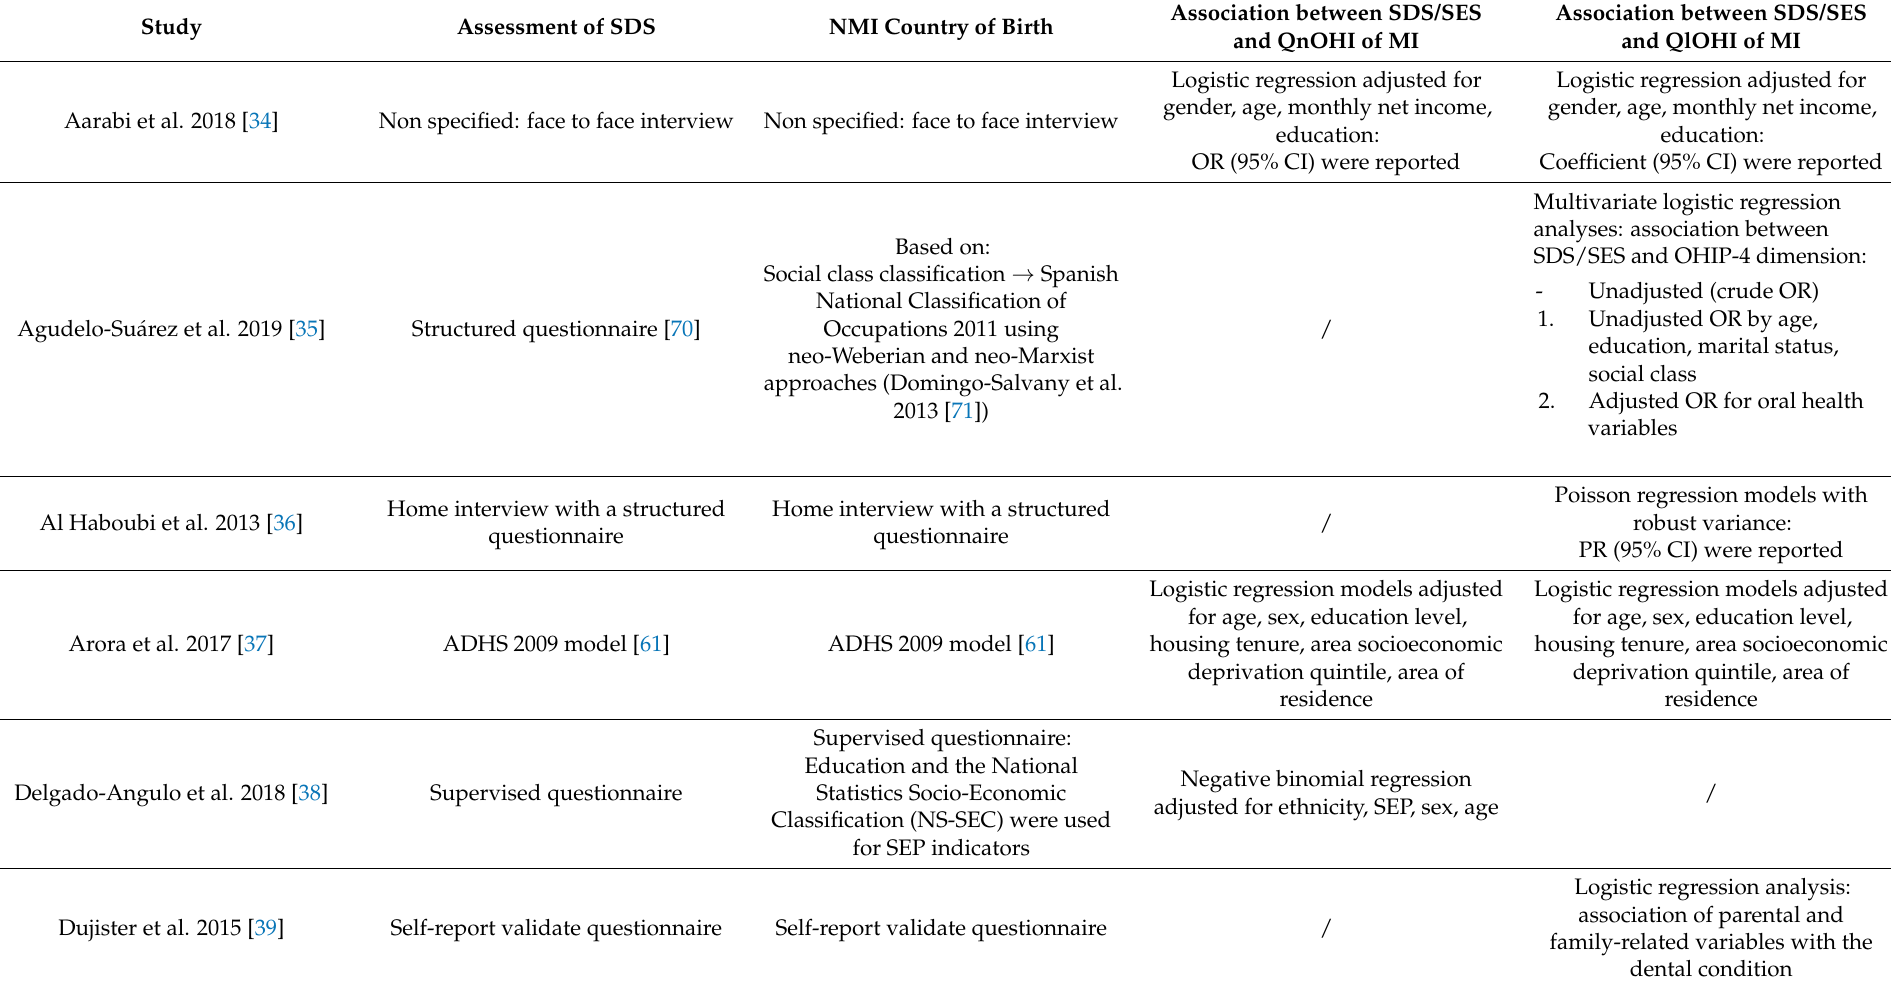
Table 8. Assessment of sociodemographic/socioeconomic status (SDS/SES), association between SDS/SES and quantitative/qualitative oral health indicators